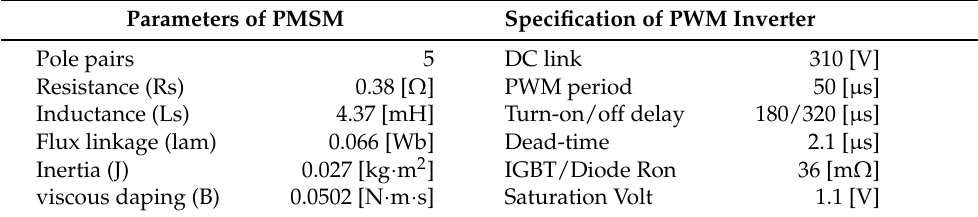
Table 4. Specification of experimental drive